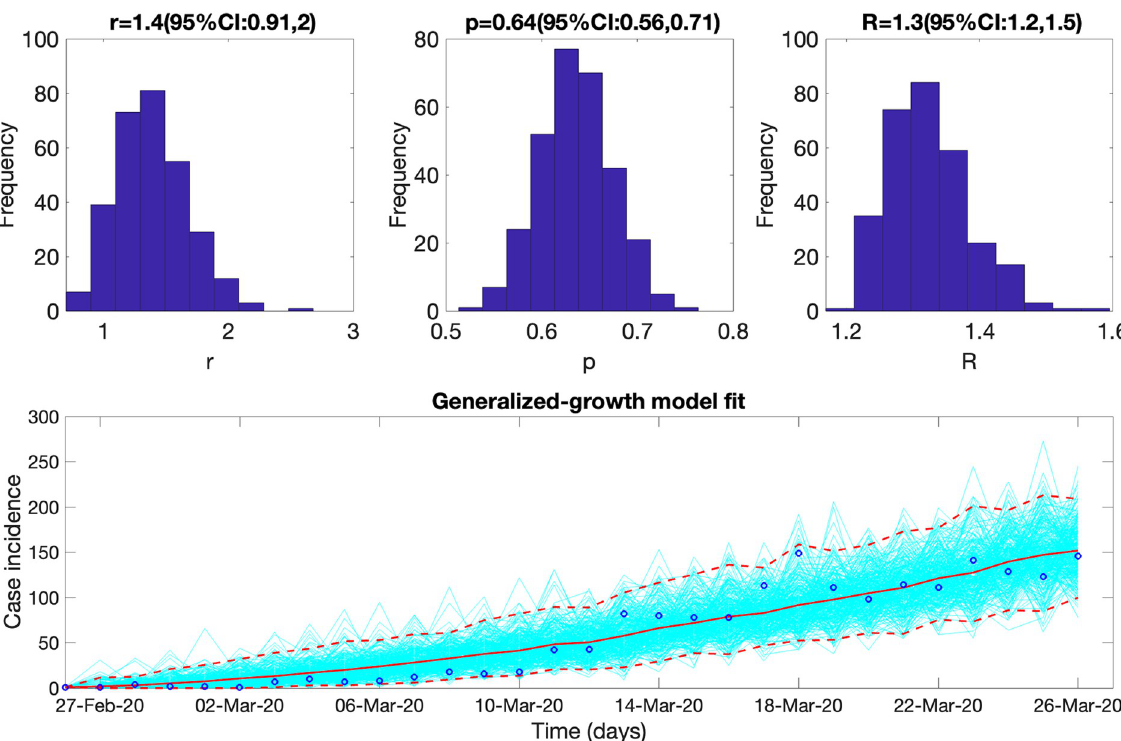
Fig 6. Upper panel: Reproduction number for Colombia with 95% CI estimated using the GGM model. The estimated reproduction number of the COVID-19 epidemic in Colombia as of March 27, 2020, is 1.30 (95% CI: 1.20, 1.50). The growth rate parameter, r , is estimated at 1.40 (95%CI: 0.91, 2.0) and the deceleration of the growth parameter, p , is estimated at 0.64 (95%CI: 0.56, 0.71) at α = 0.15. Lower panel: The lower panel shows the GGM fit to the case incidence data for the first 30 days from February 27, 2020 to March 27, 2020. The blue circles correspond to the data points; the solid red line indicates the best model fit, and the red dashed lines represent the 95% confidence interval. The cyan lines are the model fits obtained via bootstrapping.